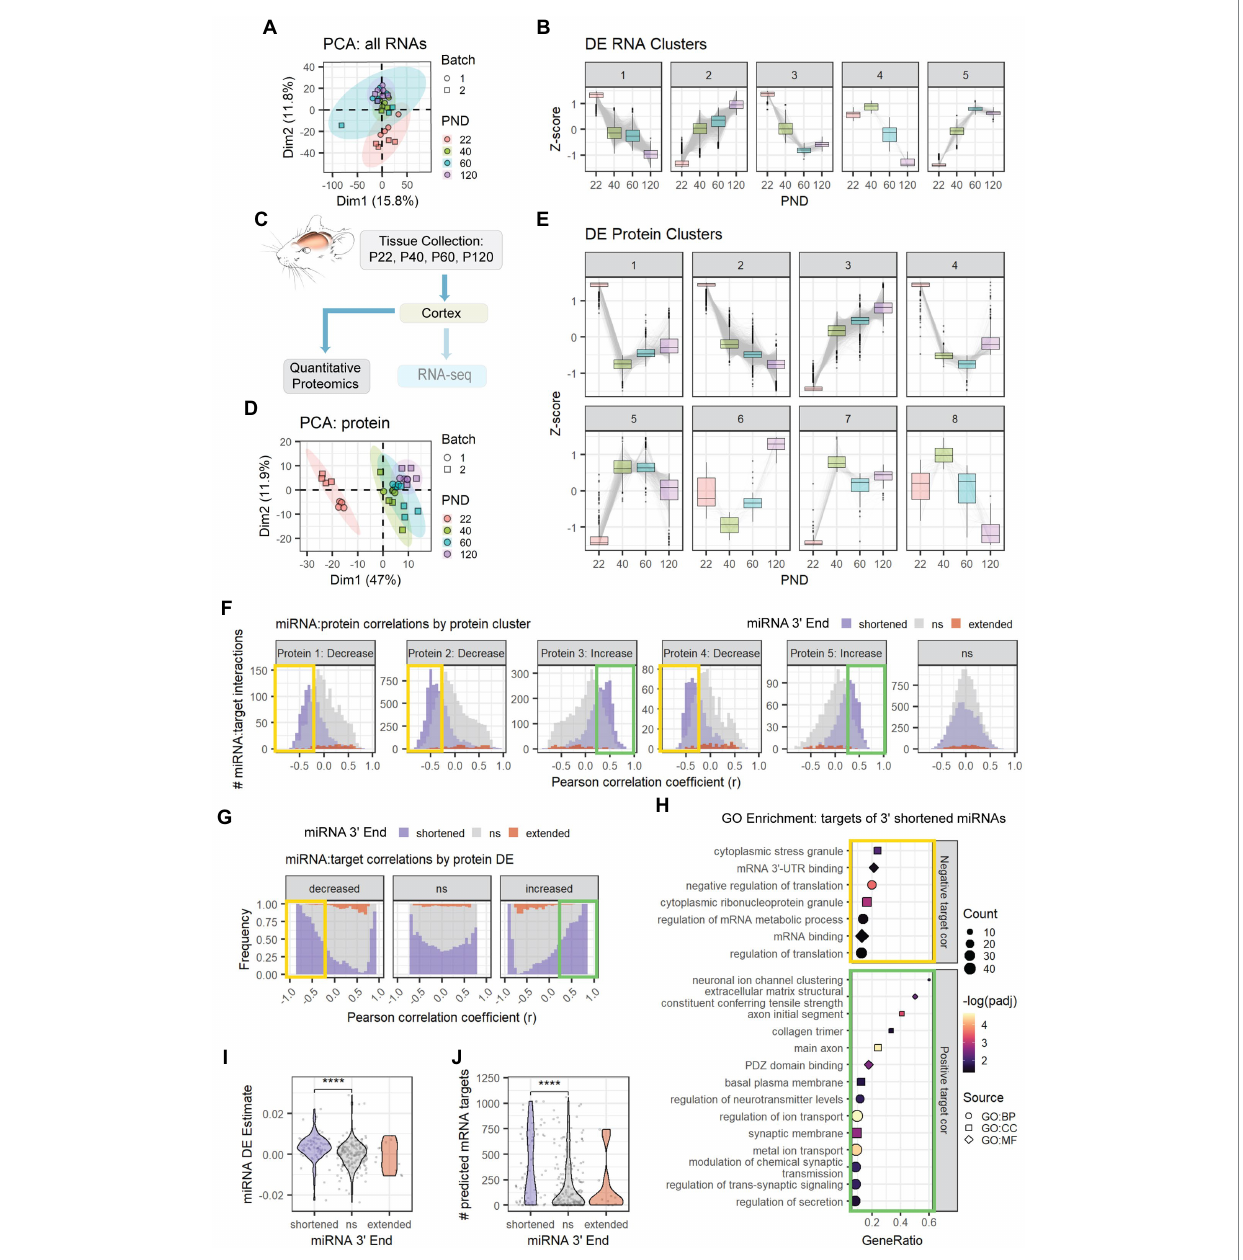
FIGURE 4 Age-associated 3 ′ shortening of miRNAs is associated with stronger correlations with target protein levels in cortex. (A) PCA was performed on count data for all RNAs in the cortex Combo-Seq data set, including mRNAs and miRNAs. QuagmiR-mapped counts were used for miRNAs. All other count data came from the exceRpt pipeline. (B) Clusters representing DE patterns for RNAs in cortex. (C) Cortical tissue sections were split after dissection, with half used for Combo-Seq and half used for quantitative proteomics. (D) PCA was performed on protein data in cortex proteomics data set. No outliers were identified. (E) Clusters representing DE patterns for proteins in cortex. (F) Pearson correlation analysis was performed for miRNAs and proteins encoded by their predicted targets in the cortex data set. Data are organized in histograms by protein cluster. Y -axis reflects the number of predicted miRNA:target interaction pairs at each Pearson correlation coefficient, r, value. Bar color reflects each miRNA’s 3 ′ end dynamics with age. (G) Pearson correlation analysis organized by protein DE results. Y -axis indicates the relative frequency of targeting by miRNAs that have shortened, extended, or stable (ns) 3 ′ ends with age. Bar color reflects miRNA 3 ′ end dynamics with age. (H) GO term enrichment analysis results for protein targets that decreased with age and exhibited negative correlations ( r < − 0.25, orange box in F,G ) or increased with age and exhibited positive correlations ( r > 0.25, green box in F,G ) with miRNAs that underwent 3 ′ shortening. Shapes indicate term sub-ontology. BP, biological process. CC, cellular component. MF, molecular function. (I) Violin plot representing the relationship between miRNA 3 ′ end dynamics with age and the miRNA’s DE Estimate, which summarizes the change in miRNA levels with age. Positive DE Estimate values reflect miRNAs that increase with age, while negative values reflect miRNAs that decrease with age. Each point represents one miRNA. Kruskal-Wallis: p = 8.7e-6. Wilcox test for pairwise comparisons: **** p < 0.0001. (J) Violin plot representing the relationship between miRNA 3 ′ end dynamics with age and the number of predicted mRNA targets detected for each miRNA. Each point represents one miRNA. Kruskal-Wallis: p = 0.00015. Wilcox test for pairwise comparisons: **** p < 0.0001. See Supplementary Figures S5, S6 for additional analyses of the cortex Combo-Seq and proteomics data sets. See Supplementary Figure S7 for corresponding hippocampus Combo-Seq data. See Supplementary Figure S8 for additional correlation analyses for the cortex data